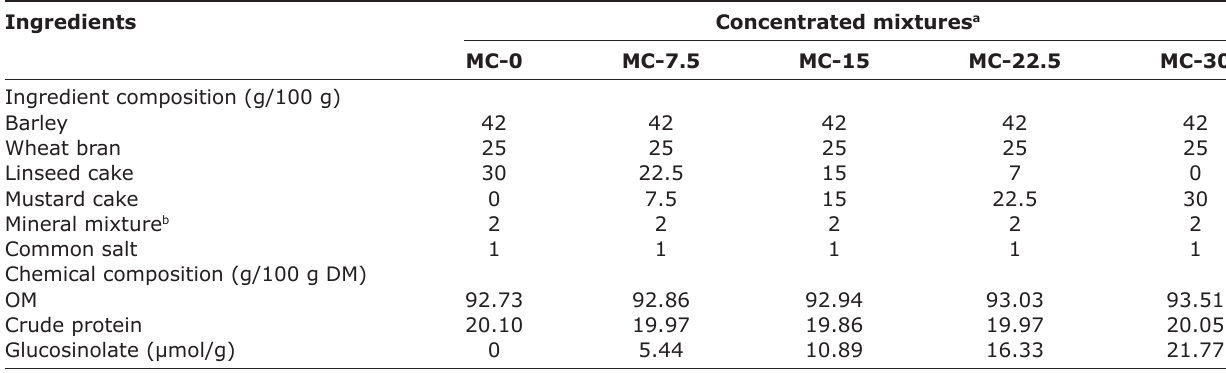
Table-1: Composition of concentrated mixture.